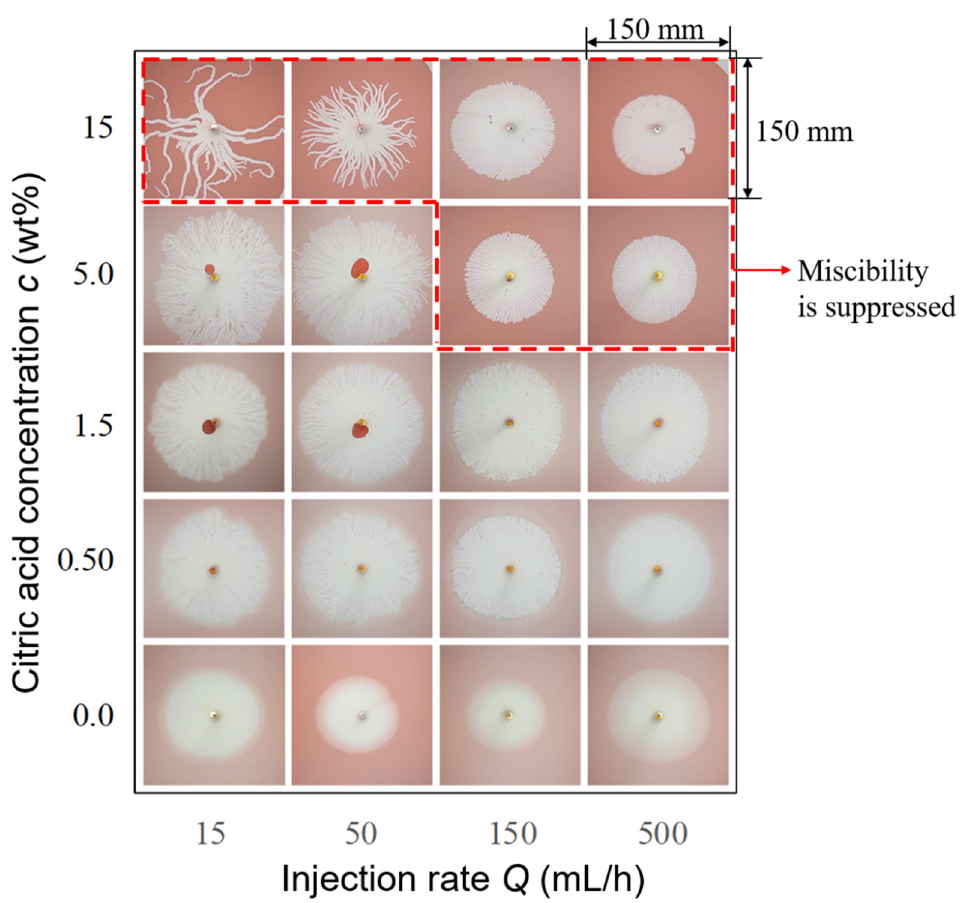
Figure 3. Displacement patterns when citric acid (white) is injected into skim milk (pink) upon injection rates of 15, 50, 150, and 500 mL/h and citric acid concentrations of 0.0 (pure water), 0.50, 1.5, 5.0, and 15 wt%. Images are taken when the injection volume of the aqueous citric acid solution is 2 mL and the gap width b is 0.4 mm. The red dash line represents the conditions at which the miscibility of citric acid and skim milk is suppressed.